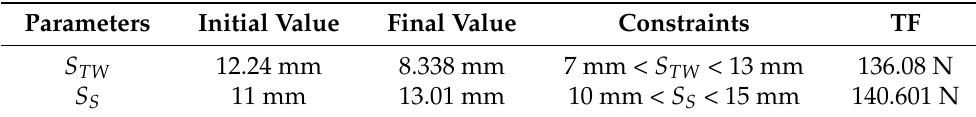
Table 4. Performance of the machine after Genetic Optimization.